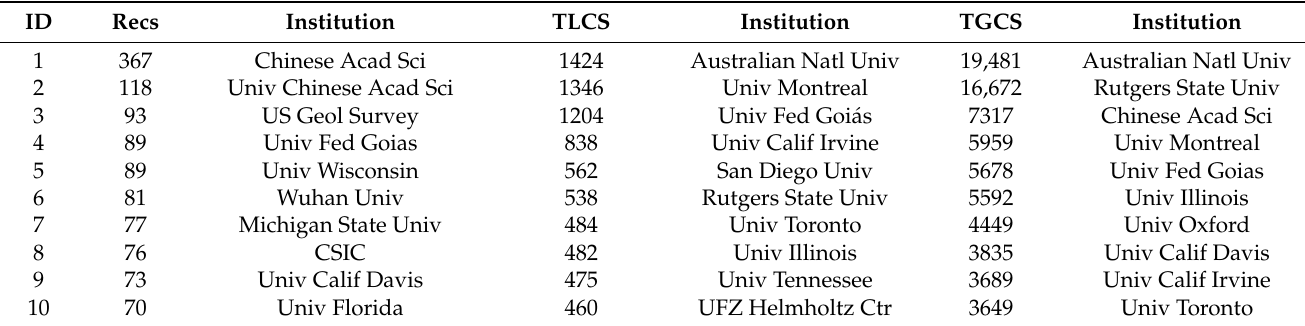
Table 4. Top ten influential institutions in terms of Recs, TLCS, and